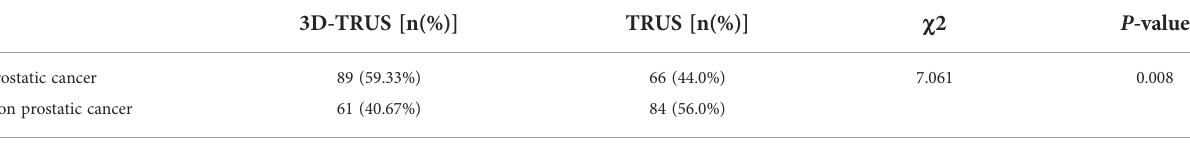
Prostatic cancer